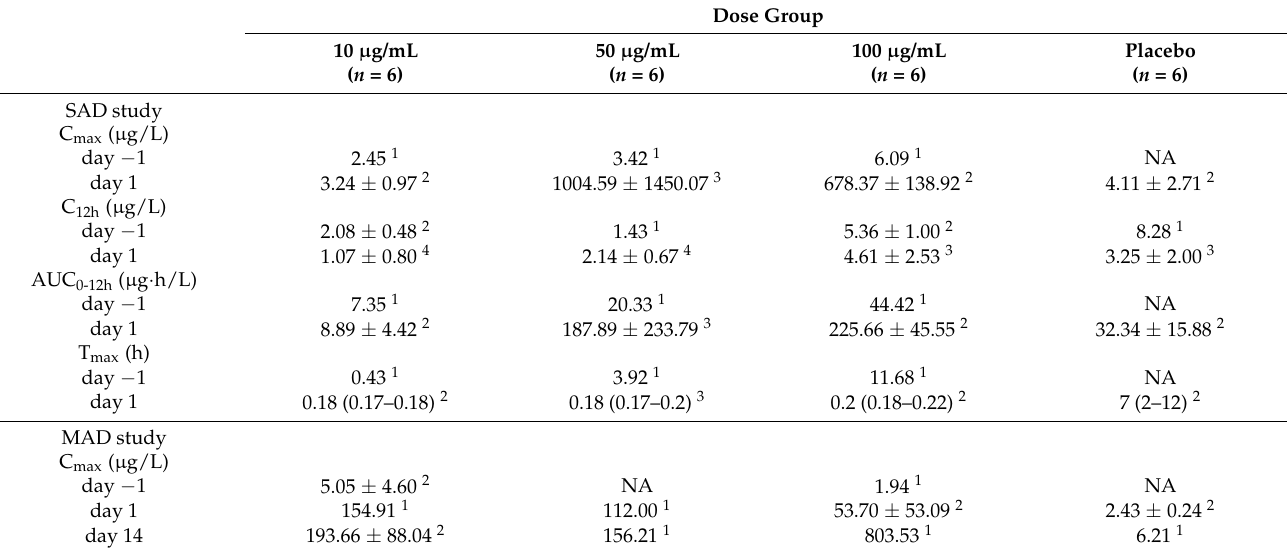
Table 3. Pharmacokinetic parameters of EGF in serum after single and multiple administration of rhEGF